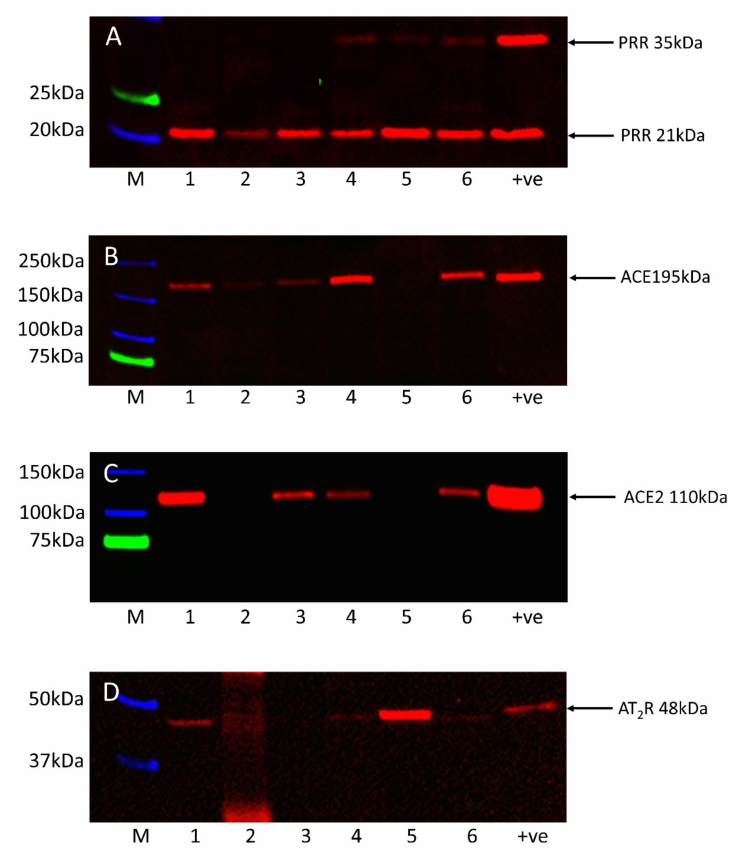
Figure 5. Representative cropped images of western blot analysis of total protein extracted from six renal clear cell carcinoma tissue samples demonstrating the presence of PRR ( A , red), ACE ( B , red), ACE2 ( C , red), and AT 2 R ( D , red). Full-length blots are presented in Figure